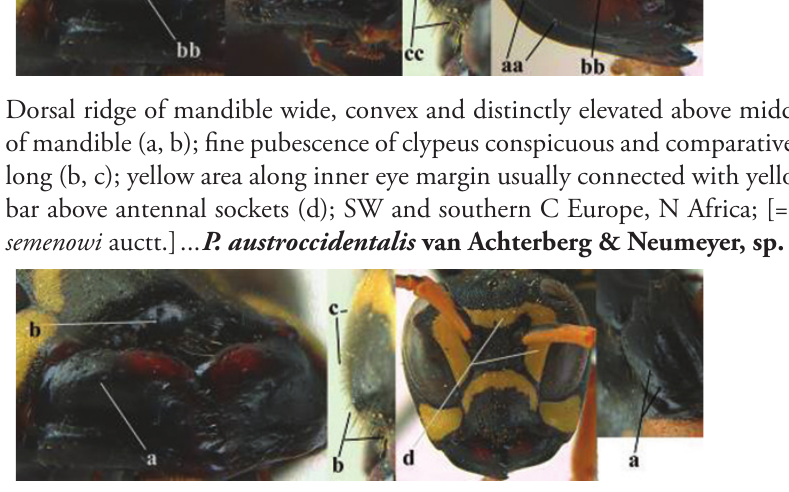
– Dorsal ridge of mandible narrow, slightly convex and hardly elevated above middle of mandible (aa); fine pubescence of clypeus inconspicuous and short (bb); yellow area along inner eye margin separated from yellow bar above antennal sockets (cc) ...................................................................................